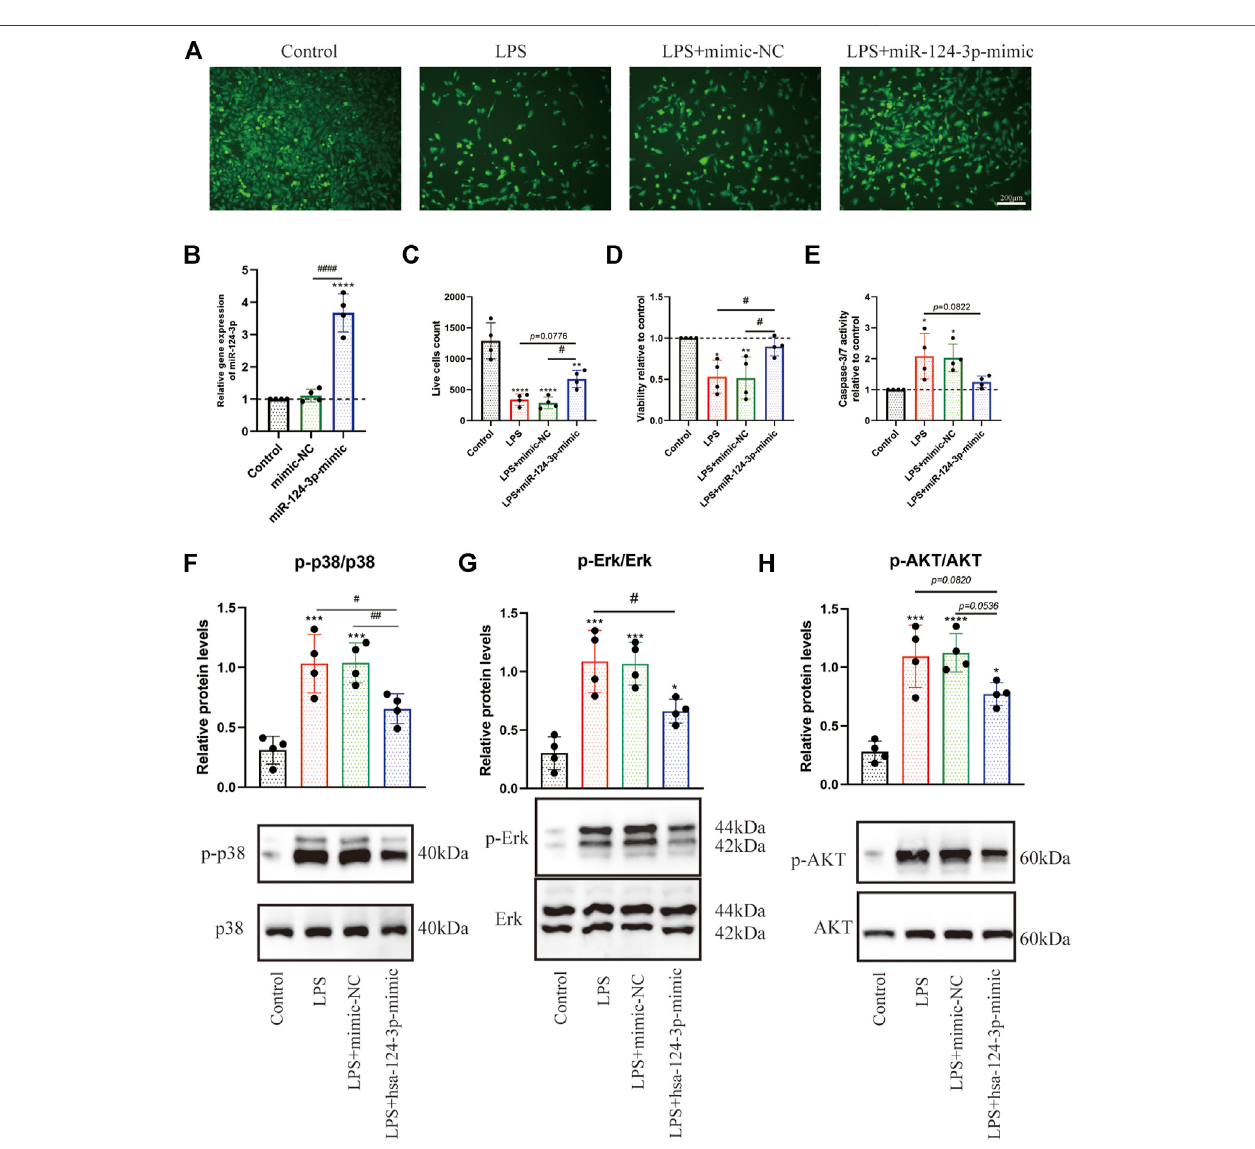
FIGURE5| hsa-miR-124-3p mimicpromotedviability,inhibitedapoptosis,andreducedphosphorylationofErk1/2,PI3K/Akt,andp38MAPKinLPS-inducedBV2 microglia. (A,C) Live cells were visualized by fl uorescence microscopy after labeling cells with calcein. Living cells were labeled with calcein (green fl uorescence); n (cid:2) 4, scale bar (cid:2) 200 μ m. (B) Relative expression of transfected hsa-miR-124-3p mimic and mimic-NC measured by qRT-PCR in BV2 microglia, n (cid:2) 4. ( D,E) Viability and apoptosis analysis of LPS-induced BV2 microglia or/and transfected with hsa-miR-124-3p mimic. (F – H) Representative Western blotting images and quanti fi cationofthephosphorylationlevelofErk1/2,P13K/Akt,andp38MAPKafterthedensitometricanalysis.Allvaluesrepresentmean ± SD.*comparedwithcontrol, * p < 0.05;*** p < 0.001;**** p < 0.0001; # Differencebetweengroups, # p < 0.05; ## p < 0.01; ### p < 0.001;one-wayANOVAwiththeNewman – Keulsmultiplecomparison test; n (cid:2)